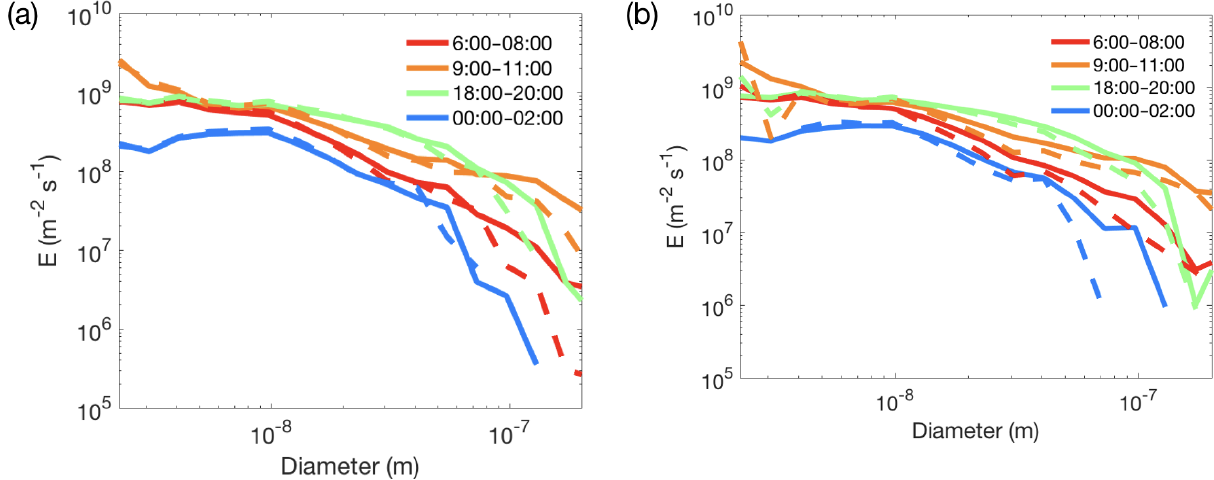
Figure A7. Average particle number emission size distributions for non-NPF event days assuming (a) GR = 3nmh − 1 (solid lines) and a GR that increases with size (dashed lines) and (b) GR = 1 . 5nmh − 1 (solid lines) and GR = 6nmh − 1 (dashed lines).